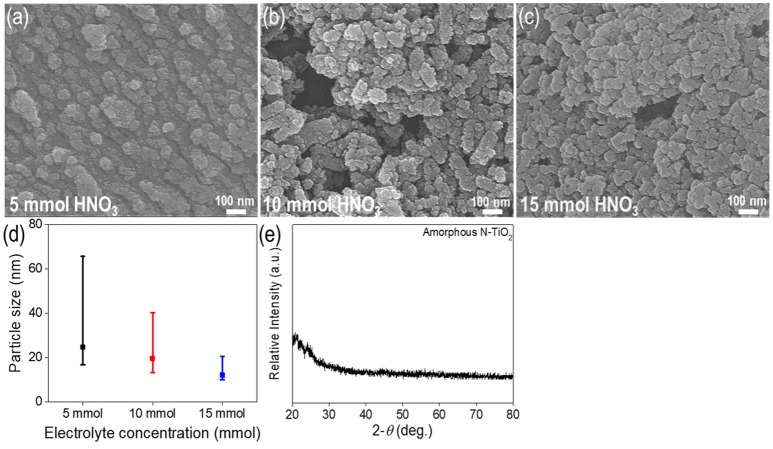
Characterization of N-TiO2 nanoparticles with various electrolyte concentrations,SEM images of (a) 5 mmol, (b) 10 mmol, (c) 15 mmol, (d) the size distribution and (e) XRD data.